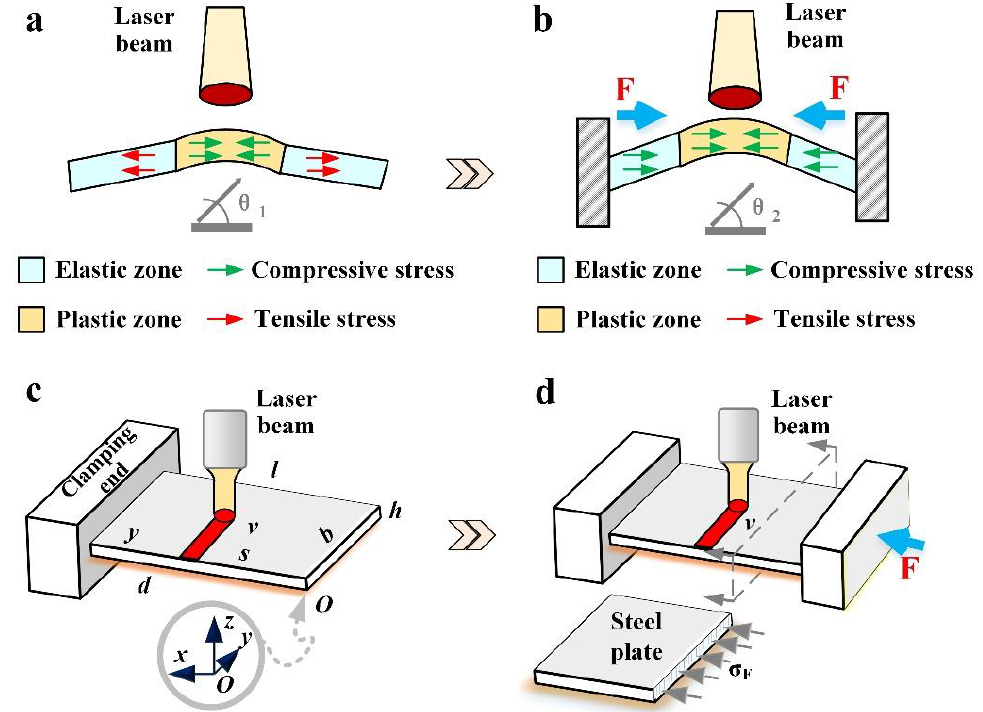
Figure 1. The comparison between the two methods: ( a ) traditional method (2D), ( b ) BPM (2D), ( c ) traditional method (3D) and ( d ) BPM (3D).